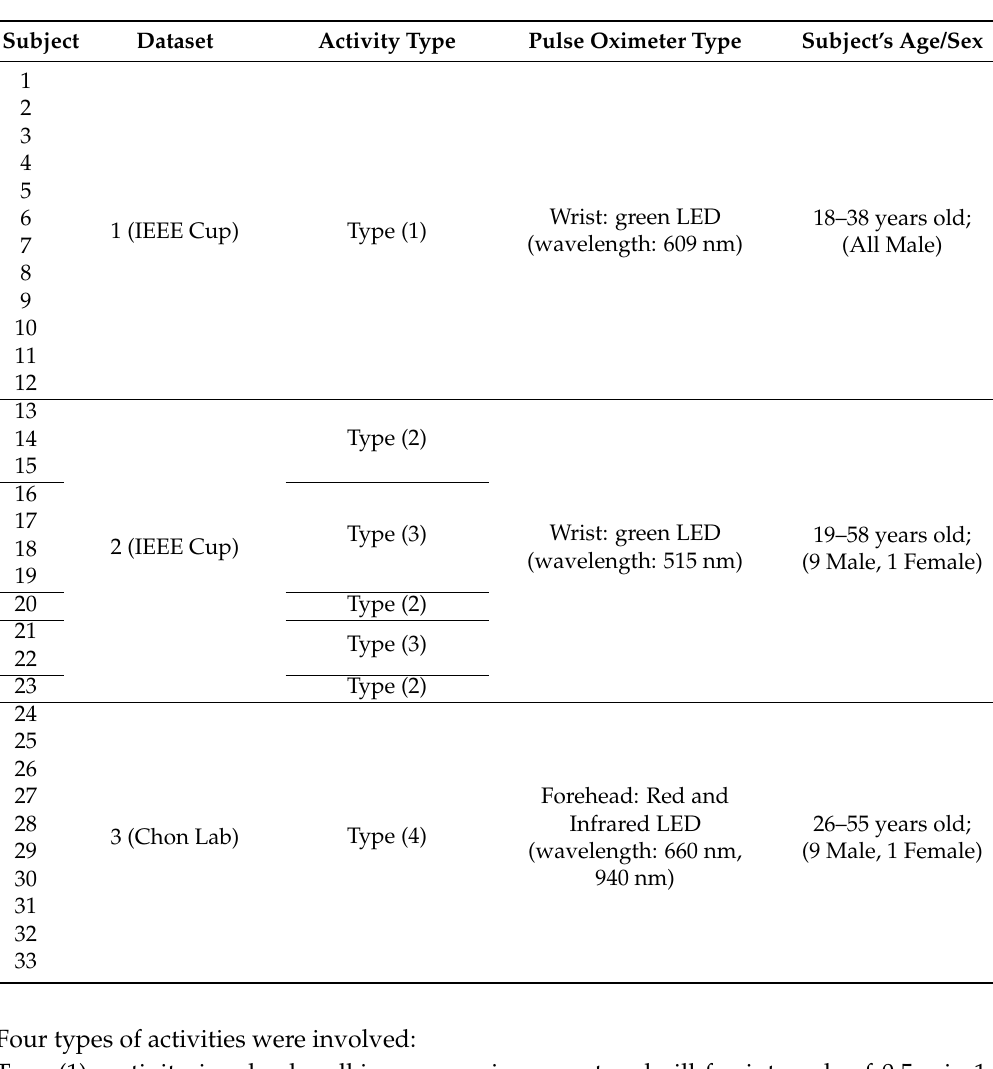
Table 1. PPG datasets and experiments